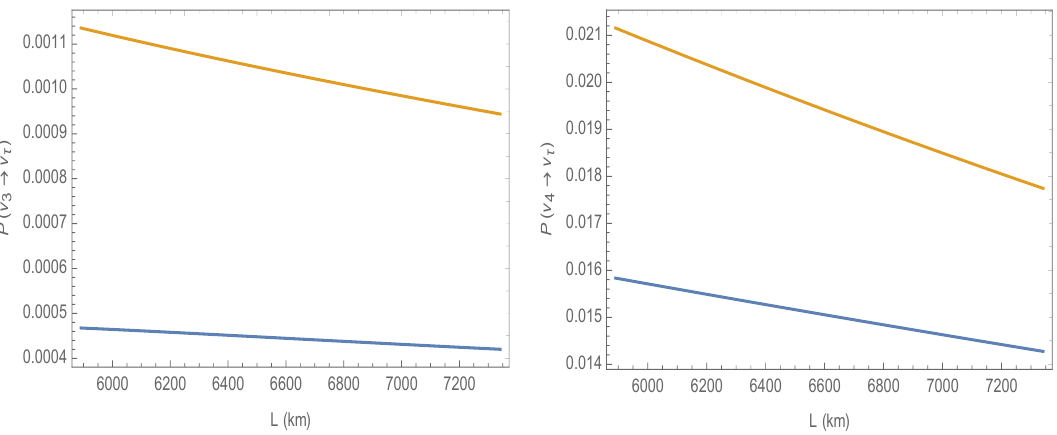
Figure 1 . Oscillation probability versus the size of the traversed chord. We have taken E ν = EeV, Γ = 0 . 003 km − 1 (corresponding to ρ = 4 . 5 gr/cm 3 and cross section of 1 . 1 × 10 − 32 cm 2 taken from [14]), | U τ 4 | 2 = sin 2 α = 0 . 1 and ∆ M 2 / 2 E ν = 0 . 35Γ which corresponds to The orange and blue lines respectively correspond to the antineutrino and neutrino